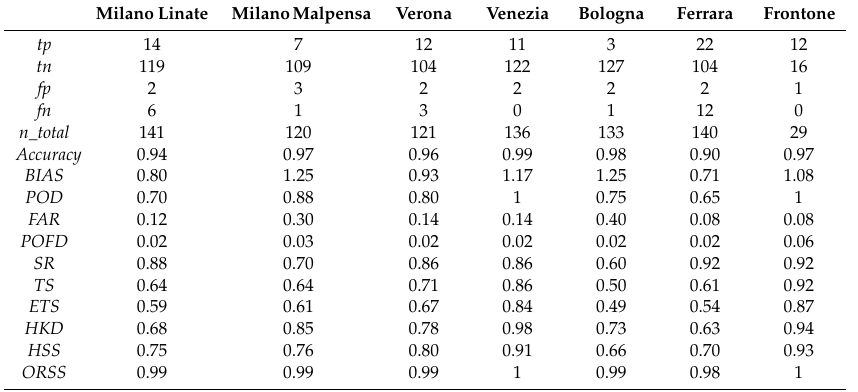
Table 13. Overall statistic performances of multitest fog forecast method for the selected sites.